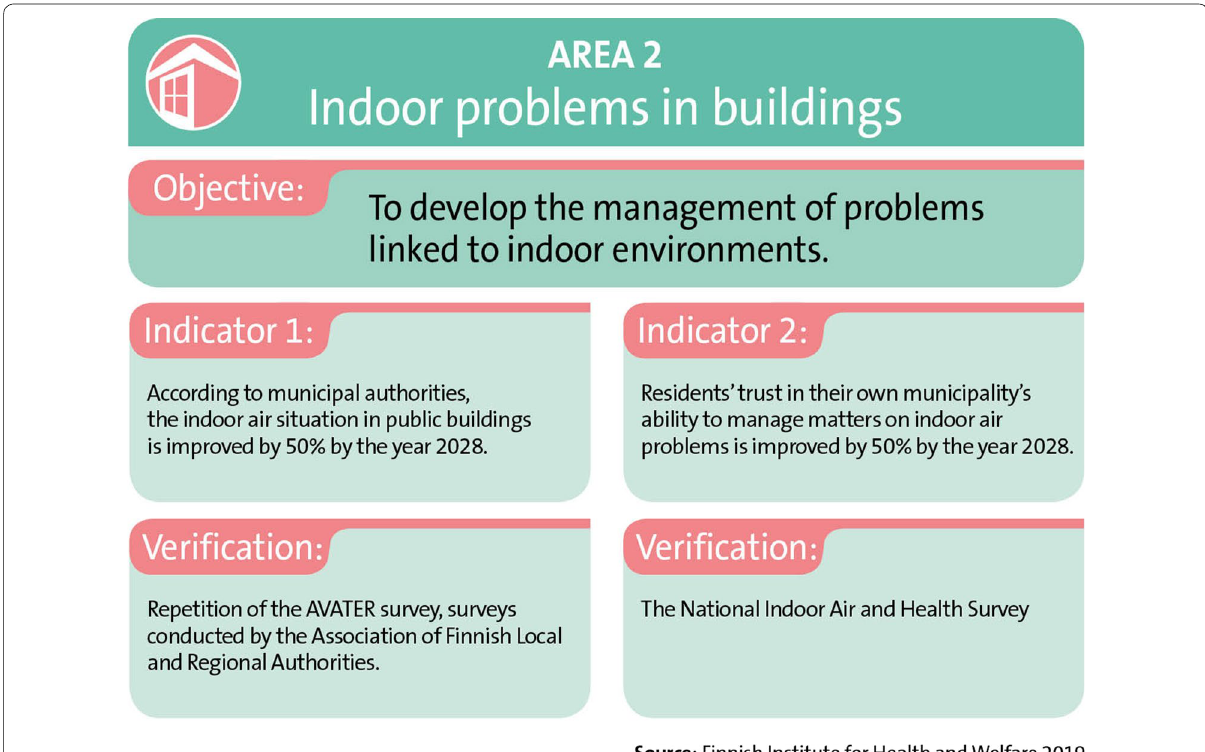
Fig. 7 The objectives, indicators, and verification sources for area